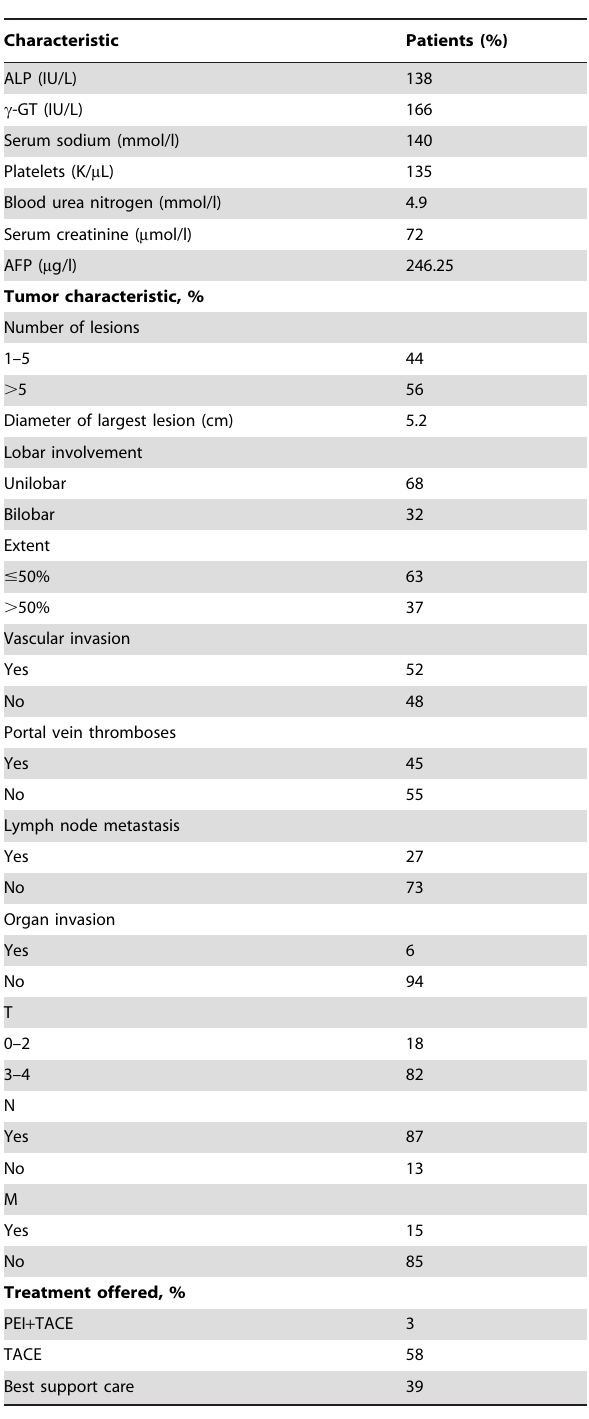
Table 1. Demographic, clinical information of 196 patients with unresectable HCC.